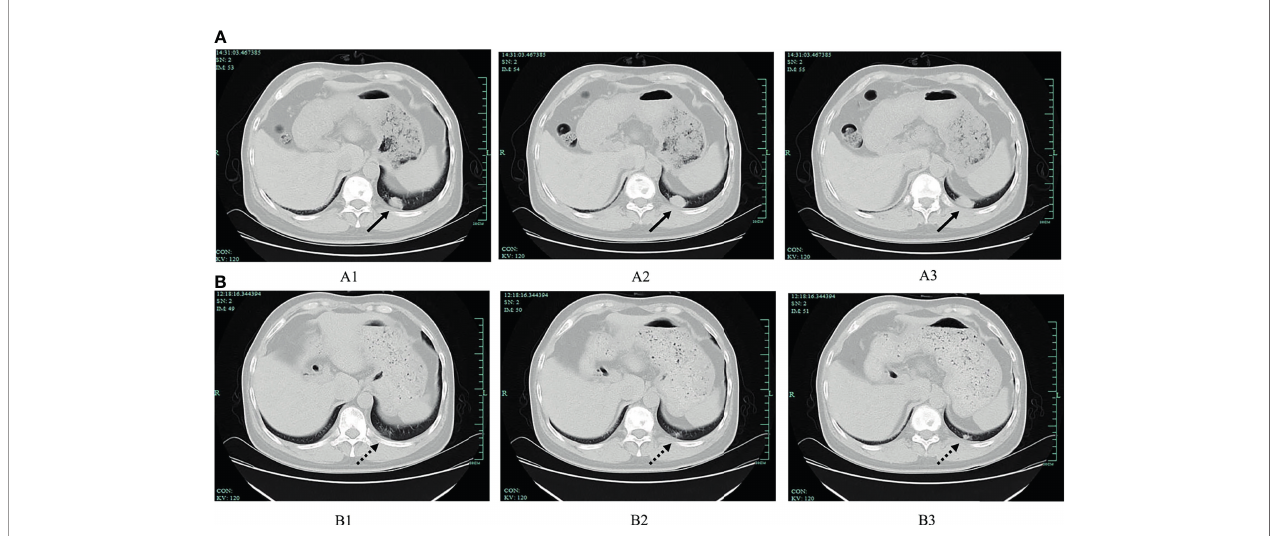
FIGURE 1 | The comparison of chest CT before and after sintilimab treatment. (A) Chest CT scan before sintilimab treatment (July 2020). Images of A1, A2, and A3 consecutively showing the tumour at the posterior segment of the left lower lobe, and the tumour size was 2.1×1.4 cm, 2.4×1.5 cm, 2.7×1.5 cm, respectively (solid lines indicate the tumour). (B) Chest CT scan after sintilimab treatment (September 2020). Images of B1, B2 and B3 showing the tumour at the same location when compared with A1, A2, and A3, separately, and the tumour size was 0.4×0.4 cm, 0.5×0.4 cm, 1.0×0.7 cm, respectively (dotted lines indicate the